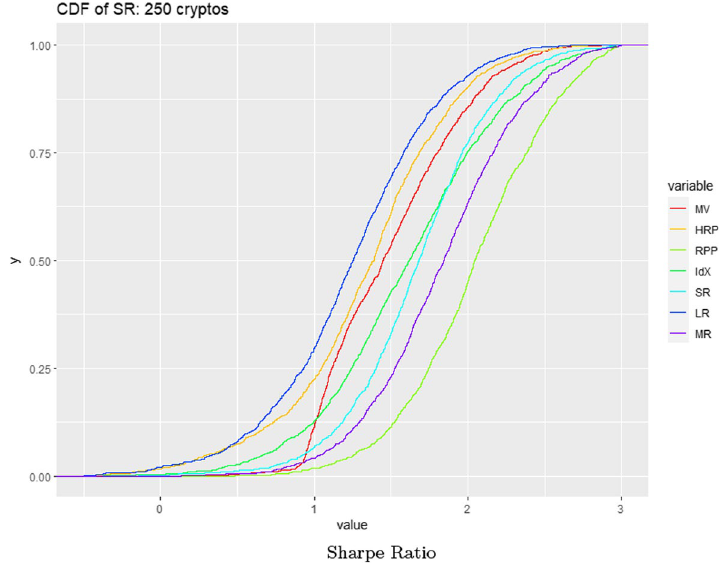
Fig. 6 Cumulative distribution of annualized sharpe ratio ( SR ann ) of the simulations (1500 random investing paths) for 250 higher marketcap